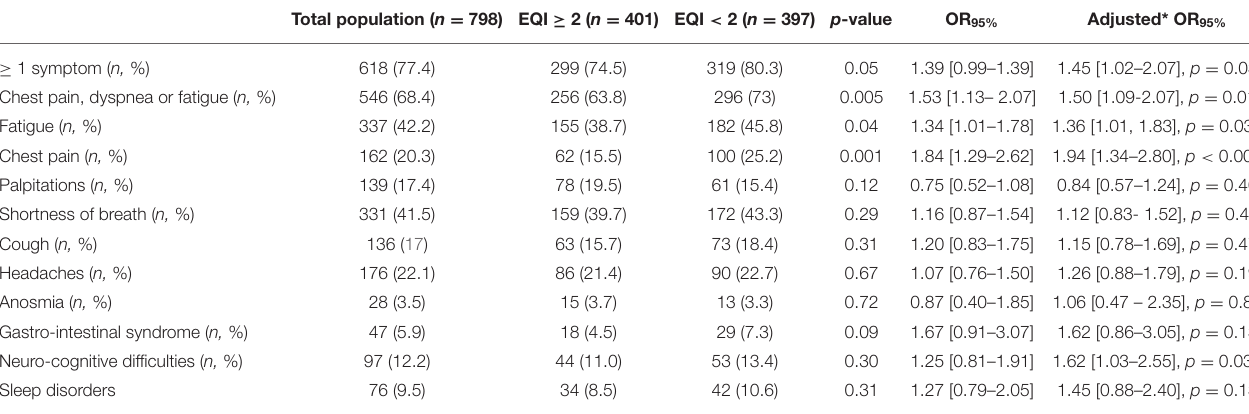
TABLE 2 | Adjusted associations of different long COVID 19 symptoms to endothelial dysfunction.